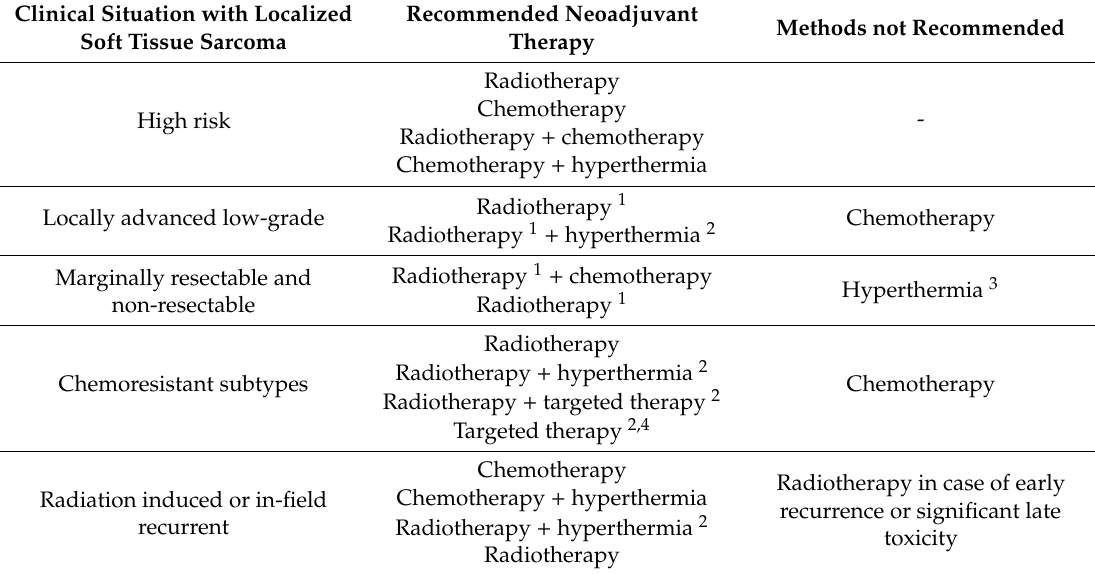
Table 5. Combinations of neoadjuvant treatment in soft tissue sarcomas in various clinical situations: authors’